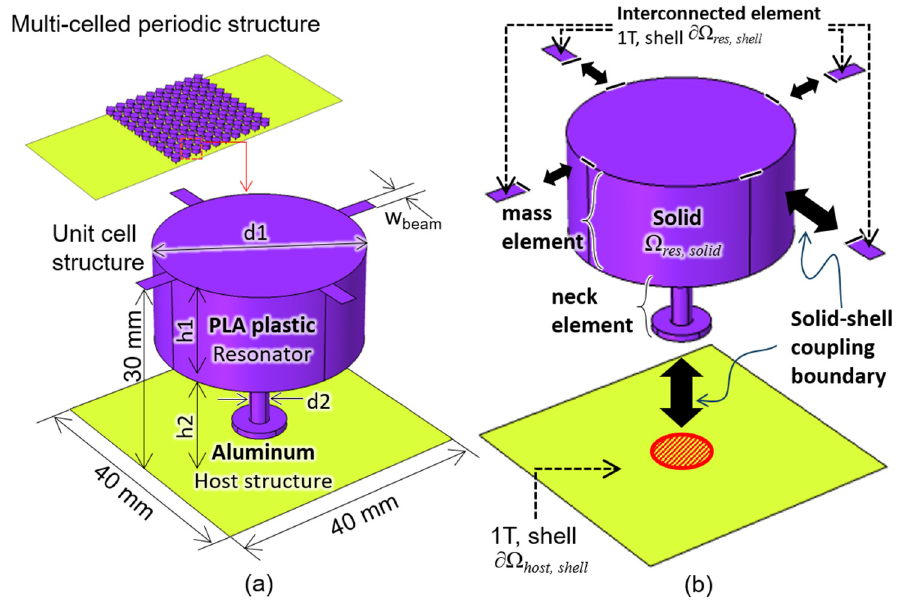
Figure 1. Conceptual diagram of an interconnected metamaterial; ( a ) dimension and material of host structure (yellow) and resonator (violet); ( b ) layout of a unit-cell structure and element type for each component.